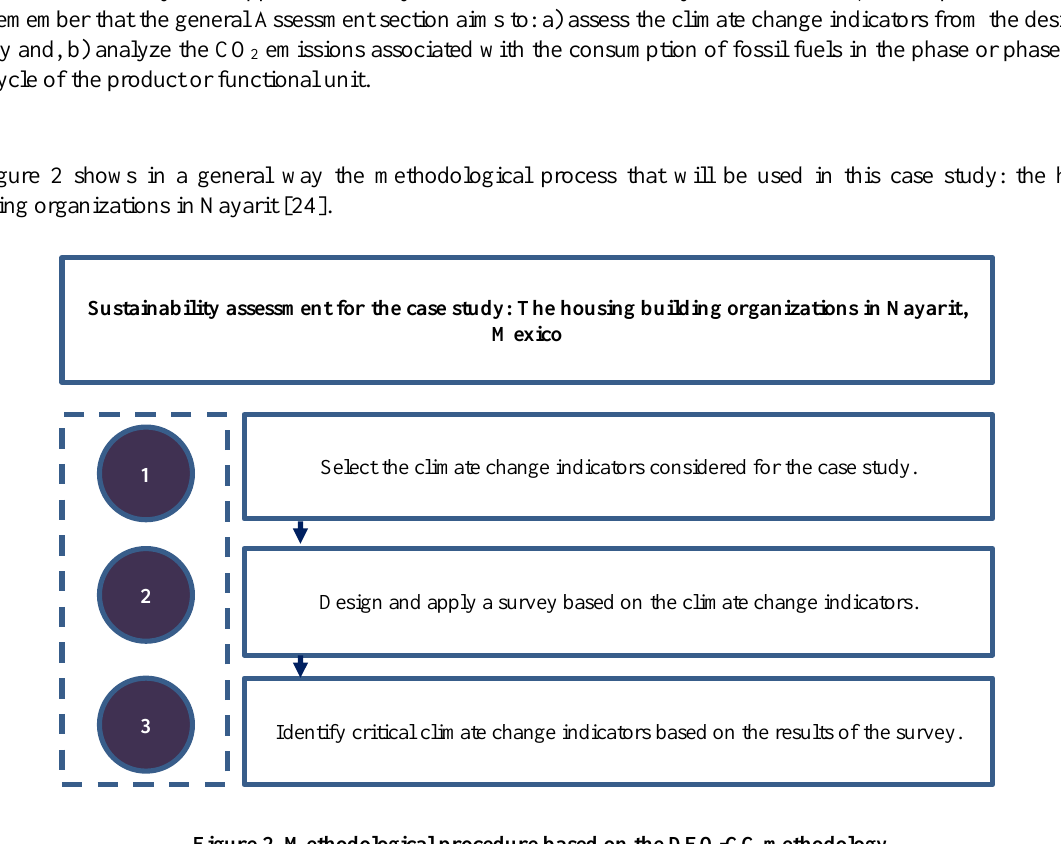
Figure 2. Methodological procedure based on the DEO-CC